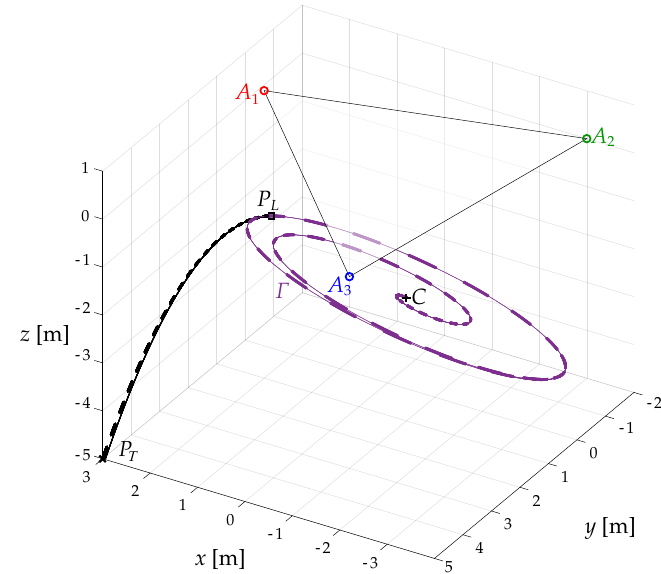
Figure 5. Ideal trajectory (dashed line) and actual trajectory (continuous).